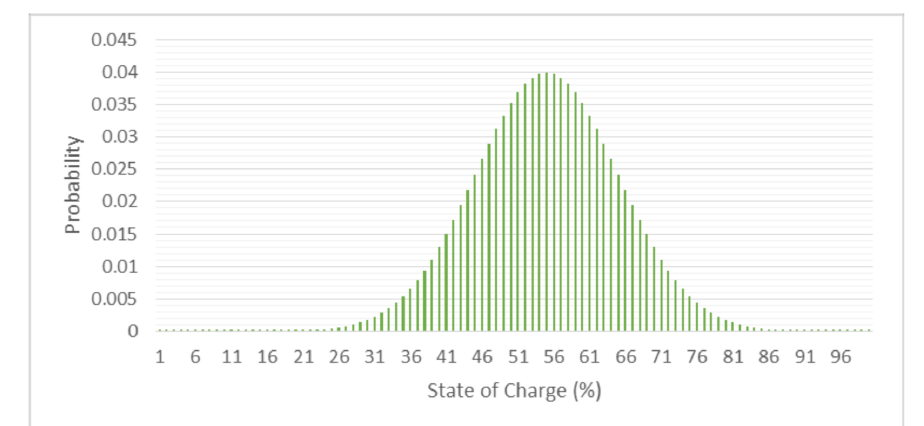
Figure 4. Probability mass function of arriving state of